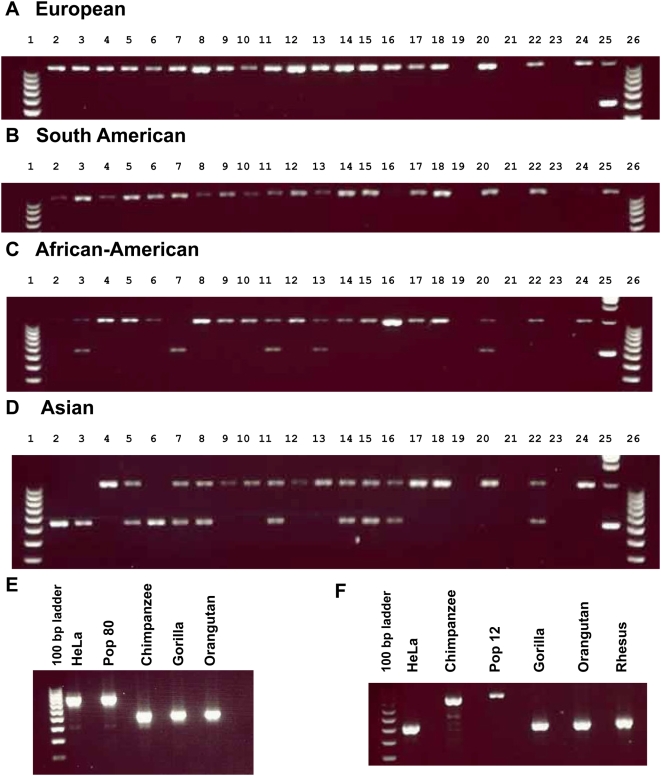
PCR analysis of human-specific and chimpanzee-specific RD.(A–D) PCR genotyping of the human-specific RD at chr15:31,987,740–31,988,005 in the 2006 hg18 assembly. For all 20 European (A) and 20 South American (B) individuals surveyed, the size of the PCR products is consistent with the homozygous presence of the acceptor sequence in all individuals tested. In contrast, among 20 African-American (C) and 20 Asian individuals (D) surveyed, several DNA samples yielded PCR products consistent with the absence of the acceptor sequence, either as homozygous [lanes 4–6 in (C) and 4, 9, and 10 in (D)] or heterozygous [lanes 3, 11, and 13 in (C) and 5, 7, and 8 in (D)]. See Table S2 for full loading orders. (E) Example of PCR validation of human-specific RD (chr10: 96,228,347–96,228,586): PCR products of size consistent with the presence of the acceptor sequence were obtained in human DNA (from HeLa cells or pooled individuals [Pop80]), while shorter PCR products, indicative of the absence of the acceptor sequence, were obtained with chimpanzee, gorilla, and orangutan DNA. (F) Example of PCR validation of chimpanzee-specific RD (chr7:136,854,307–136,854,636): PCR products of size consistent with the presence of the acceptor sequence were obtained with chimpanzee DNA (from single, “chimpanzee,” or pooled individuals [Pop12]), while shorter PCR products, indicative of the absence of the acceptor sequence, were obtained with human (HeLa cells), gorilla, and orangutan DNA.